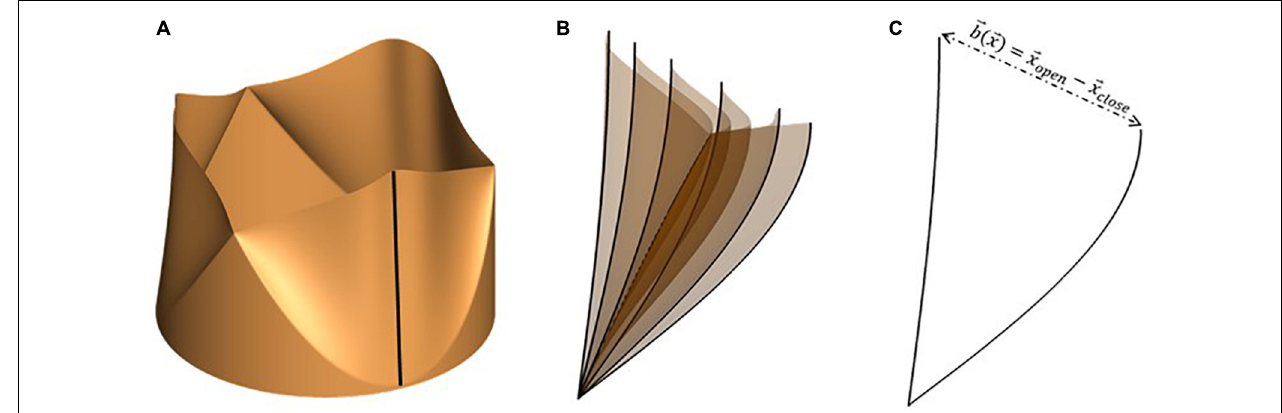
FIGURE 2 | (A) Idealized valve model with circular cross-section with leaflet centerline highlighted using a black line, (B) snapshots of leaflet centerline at several instances during valve opening and (C) leaflet centerline at maximally opened and closed configurations, indicating the local range-of-motion vector,